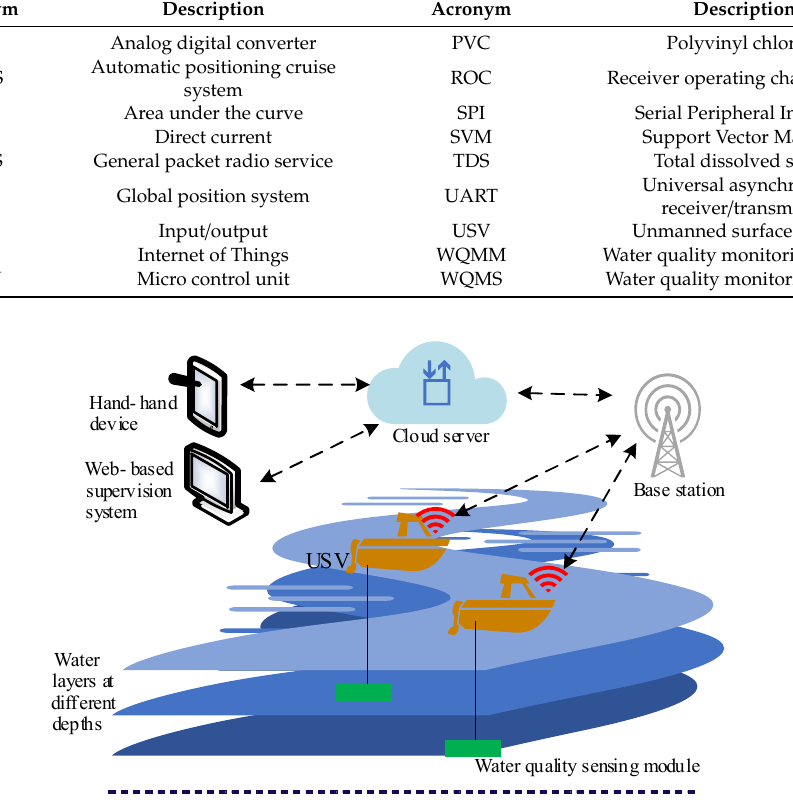
Figure 1. The overview of the proposed three-dimensional water quality monitoring system. USV, unmanned surface vehicle.